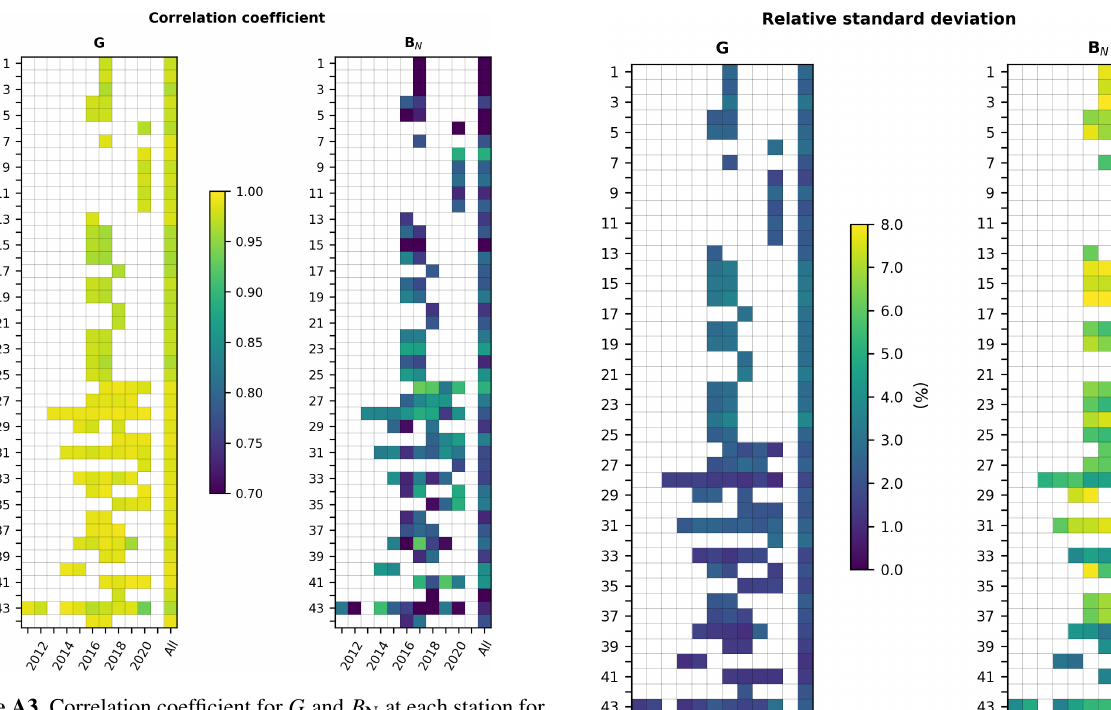
Figure A3. Correlation coefficient for G and B N at each station for each year and for the whole period (All). Numbers refer to the rank of the station in Table 1.